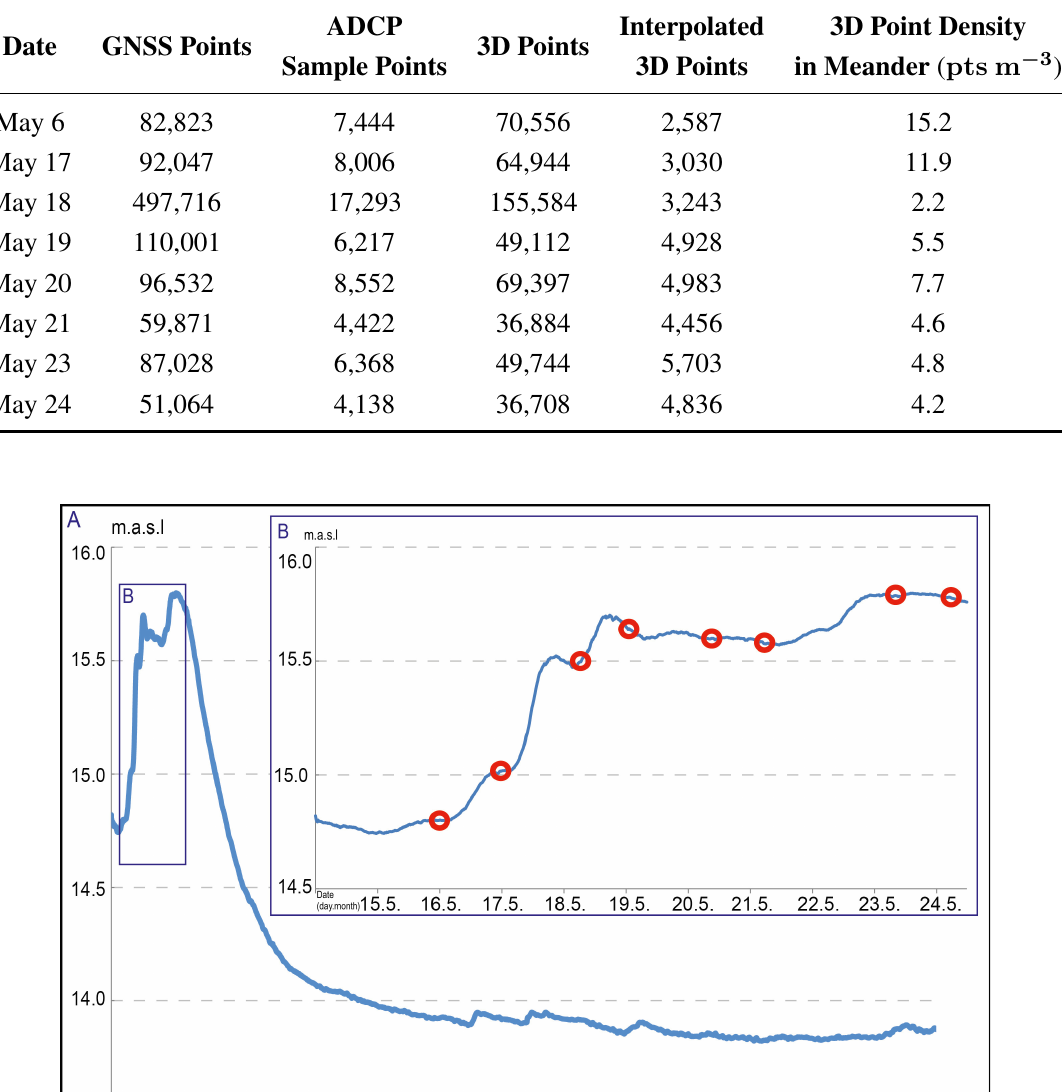
Table 1. The number of points measured for each day at the meander bend AOI. GNSS points is the number of accepted points after baseline calculation (RMSE <0.05 m). ADCP points are raw measured point samples (ensembles). 3D points are the number of points in the point cloud for each day, and interpolated points are the number of points in the regular matrix interpolated from the original point cloud. 3D point density denotes the number of points per m 3 in the meander bend AOI.